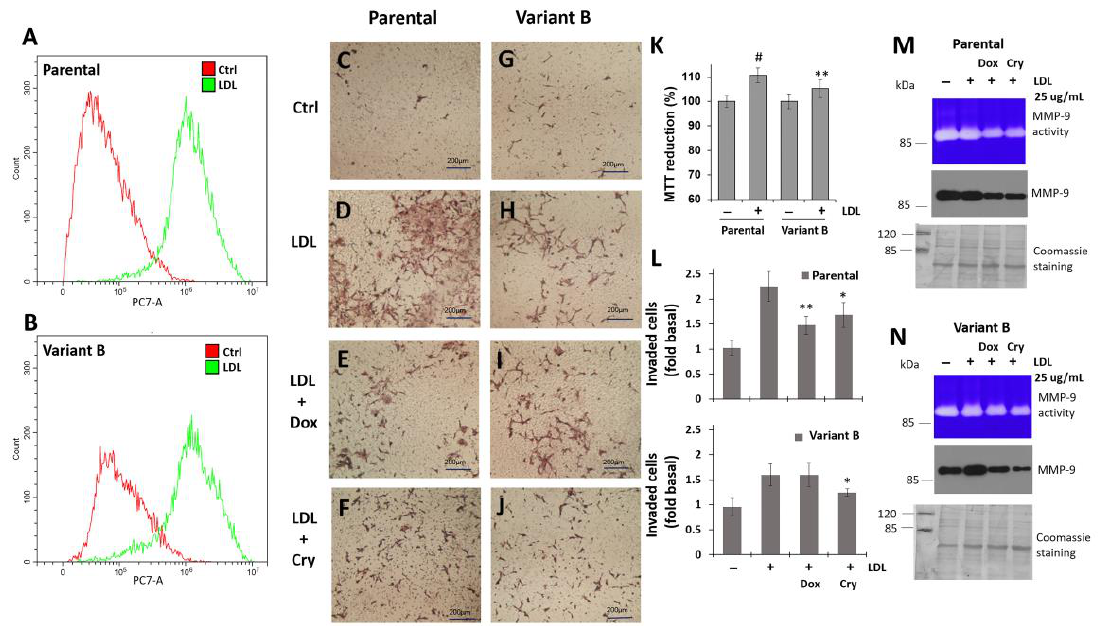
Figure 6. Cry treatment inhibits LDL-induced cellular invasion. Dil-LDL internalization by cytometer analysis in parental ( A ) and variant B ( B ) cells. Representative images of invasion experiments were obtained by optical microscopy, employing Boyden chambers. In parental cells, representative image corresponding to control ( C ), LDL treatment (20 µ g/mL) ( D ), LDL and Dox (500 nM) ( E ), LDL and Cry (25 µ M) ( F ). The same assays showed in variant B, control ( G ), LDL treatment ( H ), LDL and Dox ( I ), LDL and Cry ( J ). Bars correspond to 200 µ m. ( K ) Cellular viability in the two variants under the LDL treatment (20 µ g/mL). Mean values are presented (n = 3, mean ± SD), # p < 0.001, ** p < 0.01 with respect to control. ( L ) Semi-quantitative analysis of invasion experiments in parental and variant B cells, graphs are expressed as the fold of control. Mean values are presented (n = 3, mean ± SD), * p < 0.05 with respect to LDL treatment, ** p < 0.01 with respect to LDL treatment. Effect of Dox (500 nM) and Cry (25 µ M) on LDL induced-MMP-9 secretion in parental ( M ) and variant B ( N ) cells, activity was analyzed on the supernatant medium using zymogram gels and the expression of MMP-9 by WB. Membranes were processed with Coomassie stain as an experimental loading